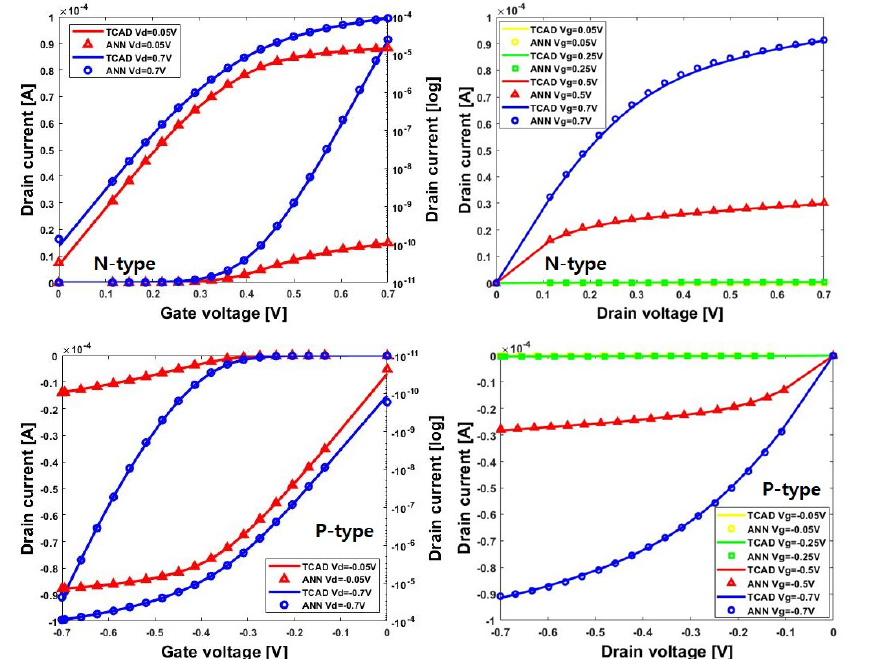
Figure 7. Comparison of the ANN model and simulated I-V characteristics using TCAD for N-type and P-type NSFETs (gate length = 12 nm, sheet width = 25 nm, sheet thickness = 5 nm, spacer length = 4 nm, oxide thickness = 1.5